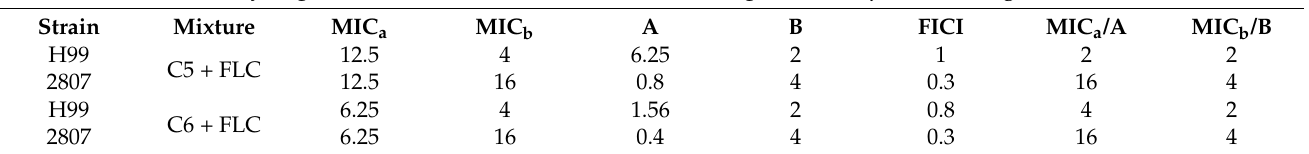
Table 4. Effect of combining the chimeric peptides and FLC against C. neoformans H99 and 2807 clinical isolate.